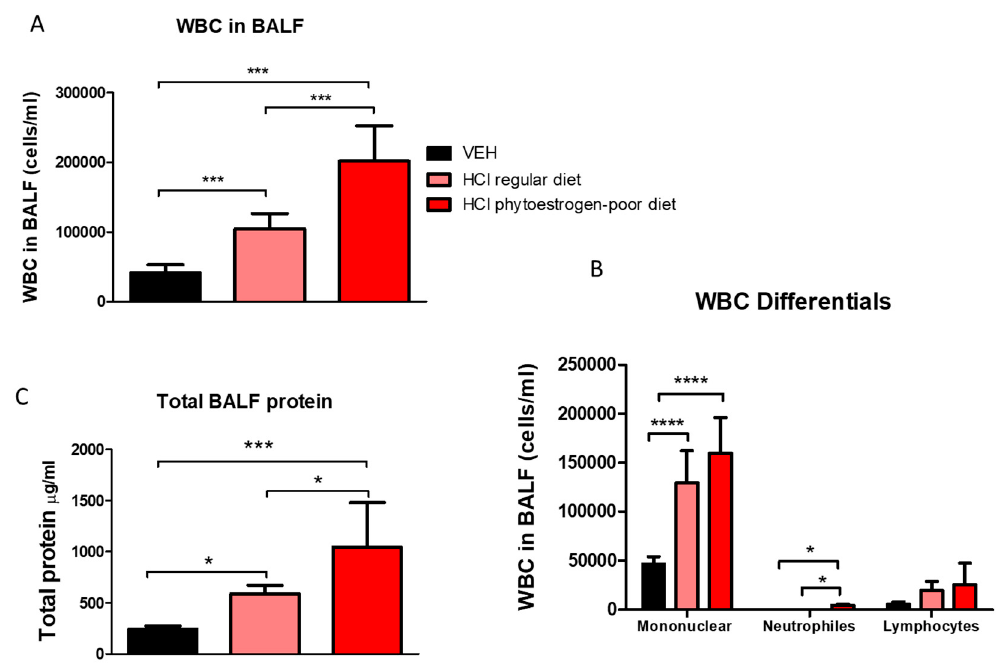
Figure 3. White blood cell (WBC) content ( A ), differential WBC content ( B ), and total protein concentration ( C ) in bron- choalveolar lavage fluid (BALF) 30 days after instillation of HCl or saline (Means ± SEM; n = 8–9; ****: p < 0.0001; ***: p < 0.001, *: p < 0.05 with one-way ANOVA and Tukey’s; VEH: Vehicle.